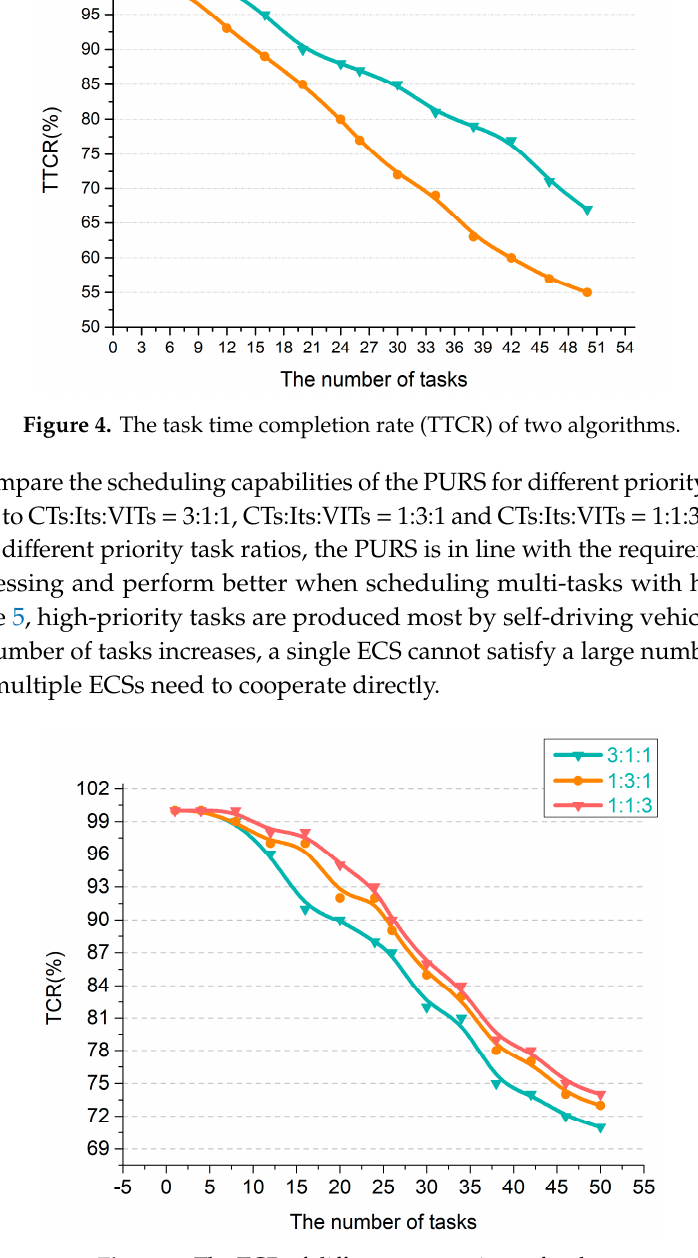
Figure 3. The task completion rate (TCR) of two algorithms.